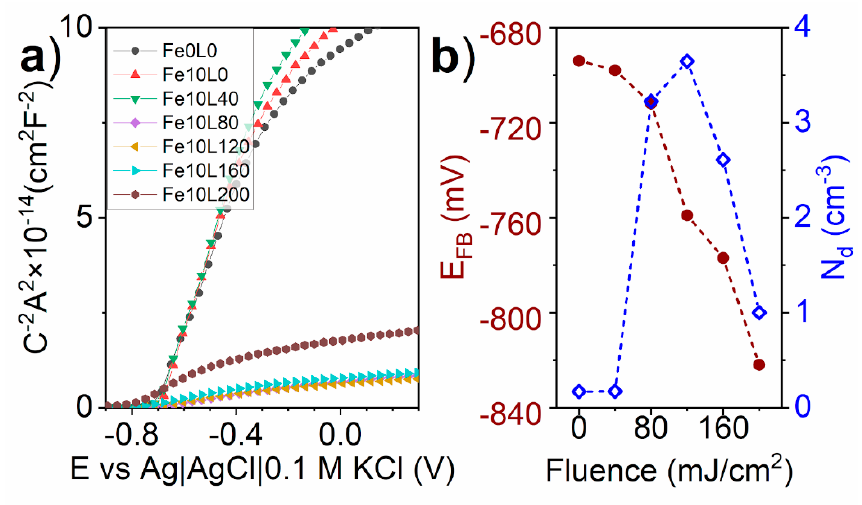
Figure 12. Mott-Schottky plots for bare and laser-annealed Fe-decorated TiO 2 -NTs ( a ), and E FB and N d as a function of laser fluence ( b ).